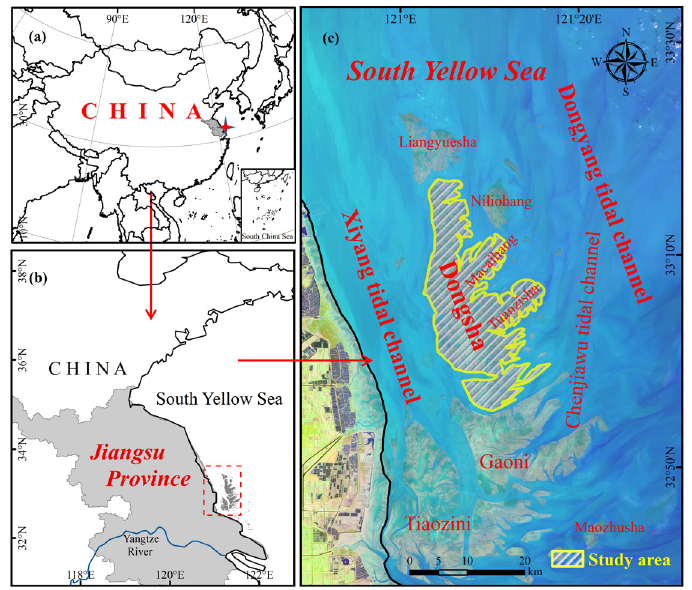
Figure 1. Study area and image of the Dongsha Shoal for a low tide condition. Maps of the Dongsha Shoal ( a ) Mainland China, ( b ) the South Yellow Sea and ( c ) Dongsha Shoal. The Dongsha Shoal is a macro-tidal area with an average tidal range of 3.9–5.5 m and exhibits an irregular semi-diurnal tide [49]. The distribution of the tidal range has Jiang- gang at the highest point with a gradual decrease towards the north and south sides [50].